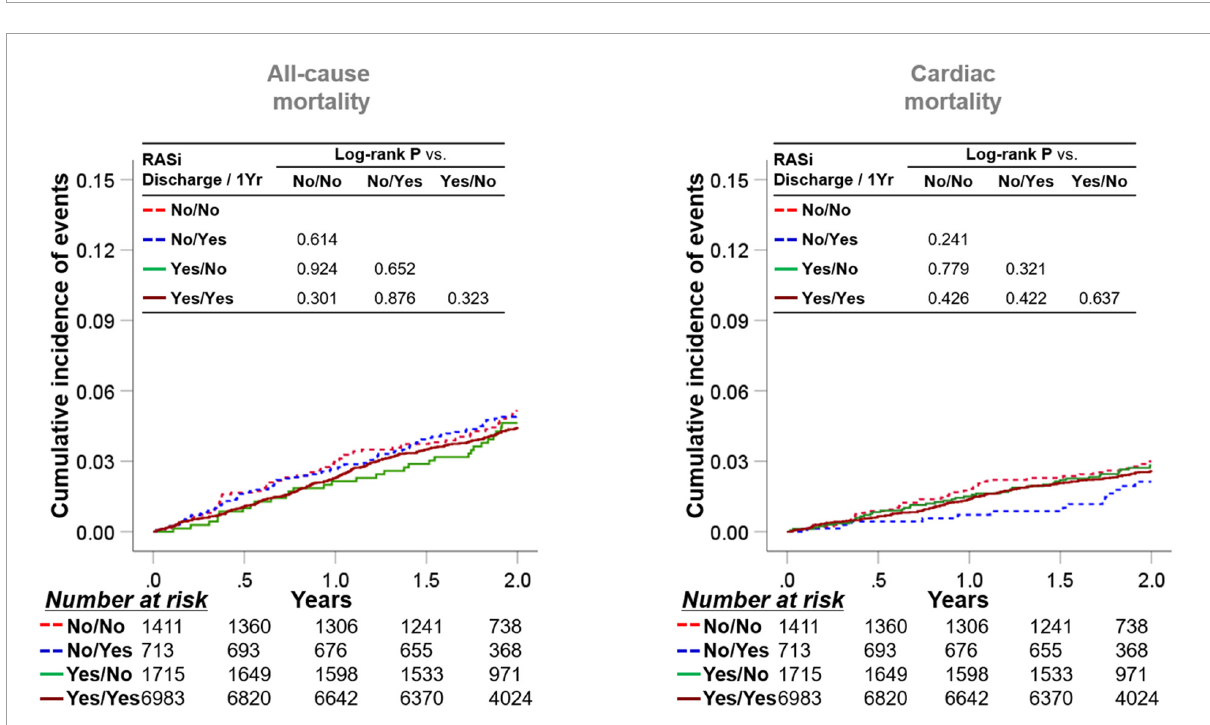
FIGURE3 Implication of RASi stratified by medication at discharge and at 1-year follow-up. Patients were categorized into four subgroups according to the RASi medication at discharge and at the 1-year follow-up. Kaplan-Meier survival curves for 2-year all-cause mortality and cardiac mortality from the 1-year follow-up are illustrated. RASi: renin-angiotensin-system